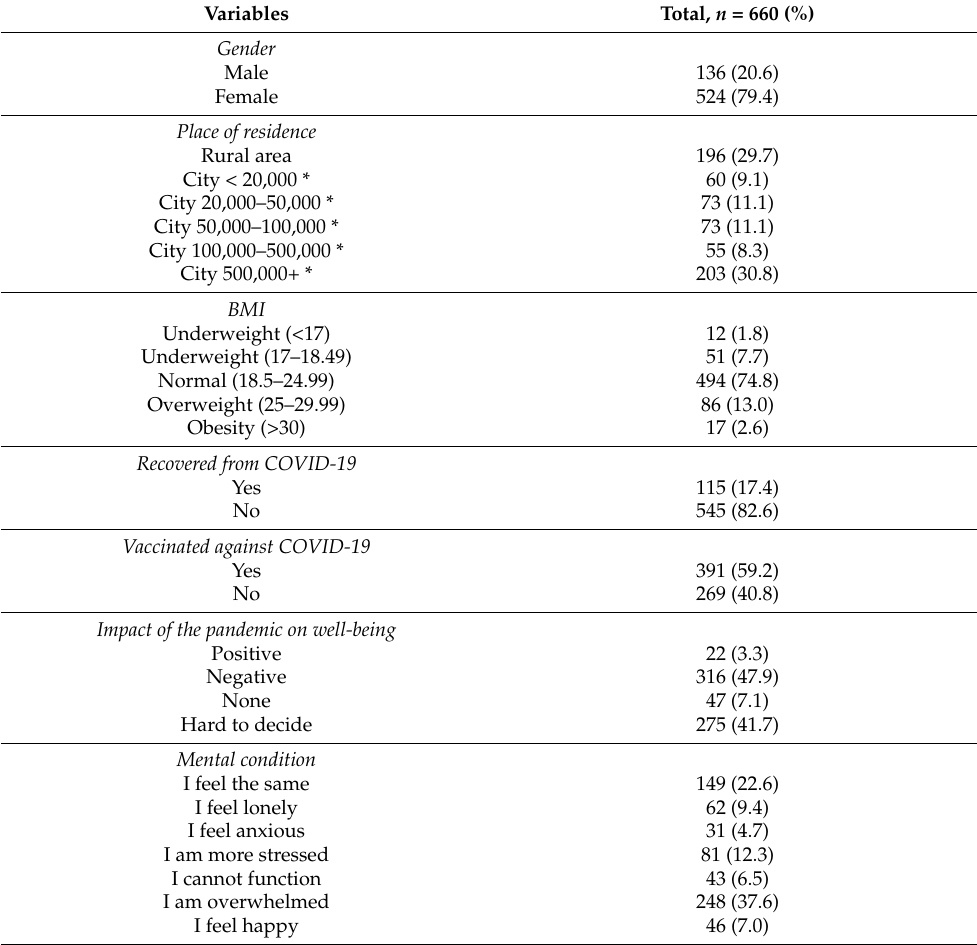
Table 1. Characteristics of study